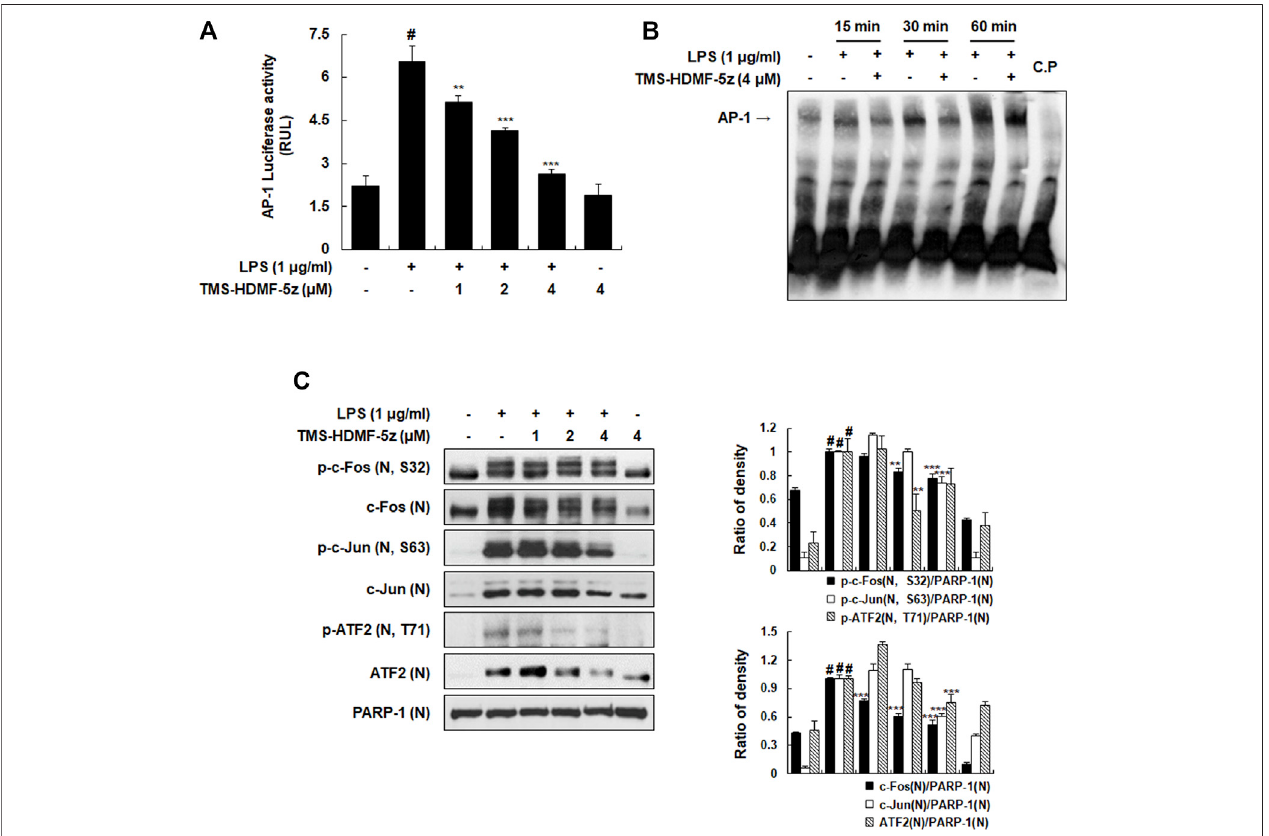
FIGURE 3 | Inhibitory effects of TMS-HDMF-5z on the LPS-induced AP-1 activity and signaling in RAW 264.7 macrophages. (A) AP-1 luciferase activity in whole cells extracts was determined using the Promega Luciferase Assay System (Promega Corp., WI, United States). (B) The DNA-binding activity of AP-1 was determined usingEMSA. (C) Thenuclearp-c-Fos(S32),c-Fos,p-c-Jun(S63),c-Jun,p-ATF2(T71),andATF2weredetectedusingwesternblotting.Therelativeopticaldensityratio vs. PARP-1 was determined using a densitometric analysis program (Bio-Rad Quantity One Software, version 4.6.3 (Basic), Bio-Rad Laboratories Inc., CA, UnitedStates),normalizedtotheinternalcontrol.Dataareshownasthemean±S.D.ofthreeindependentexperiments. # p < 0.05 vs .thecontrolgroup, **p < 0.01, ***p < 0.001 vs . LPS-treated